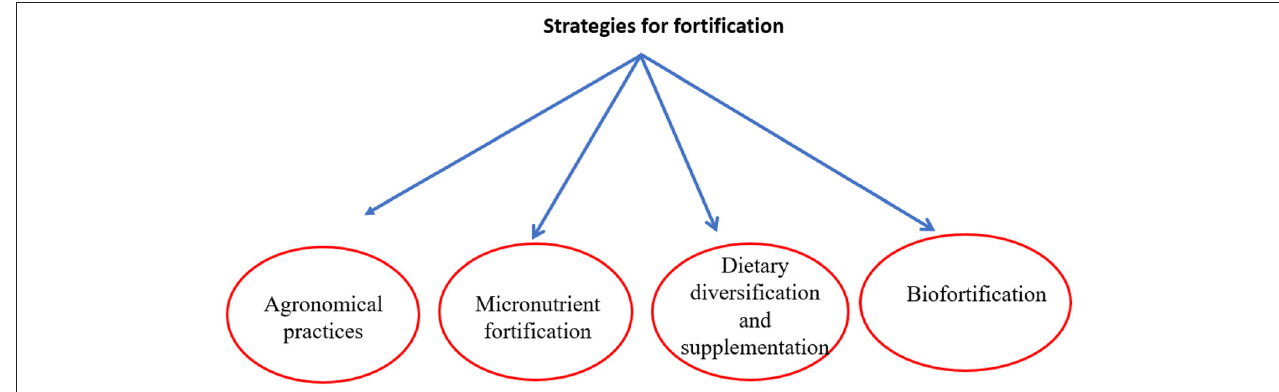
FIGURE 1 | Strategies of food fortification to improve micronutrient